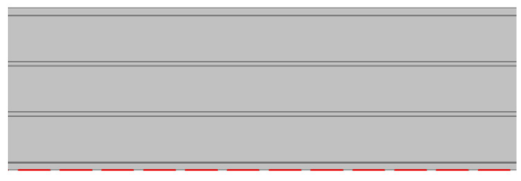
Figure 10. Layered material.